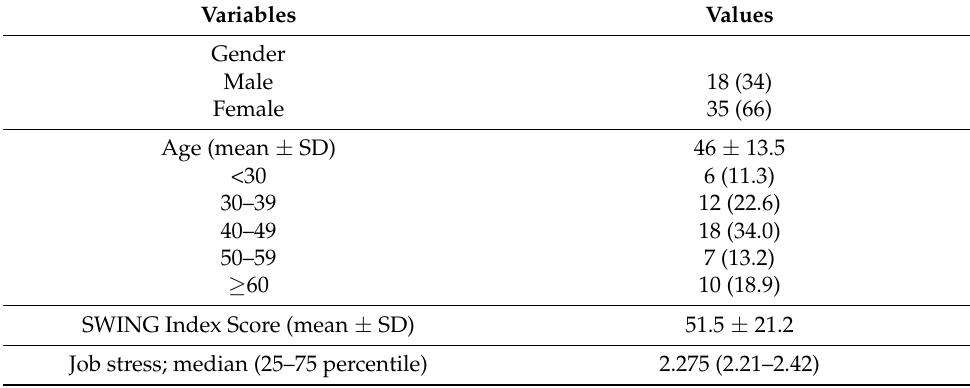
Table 2. Characteristics ( n = 53).